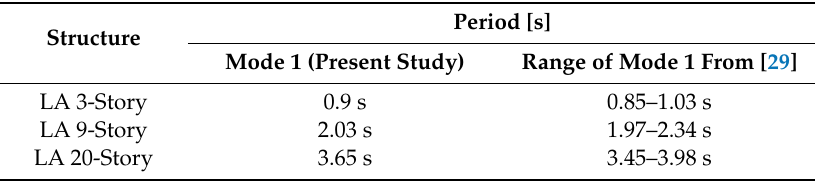
Table 1. Periods of the analyzed building from other